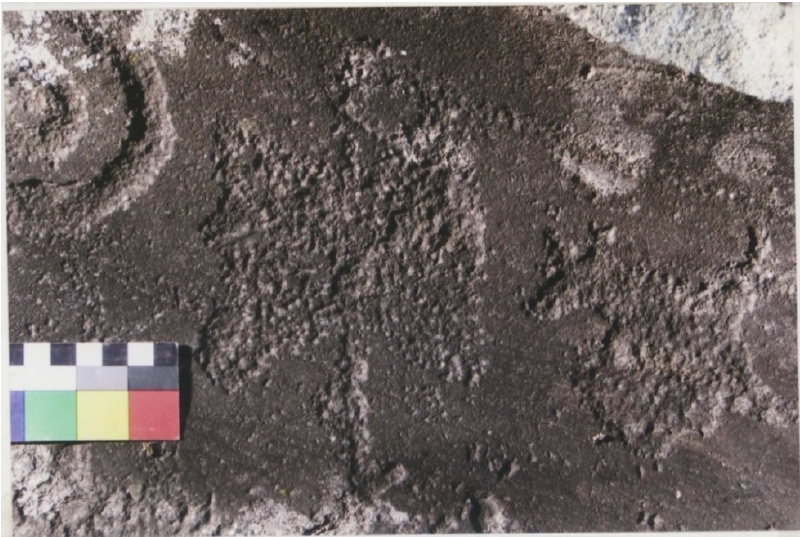
Figure 14. Atl-atls at the Jeffers Petroglyph Site in southwestern Minnesota. A date of